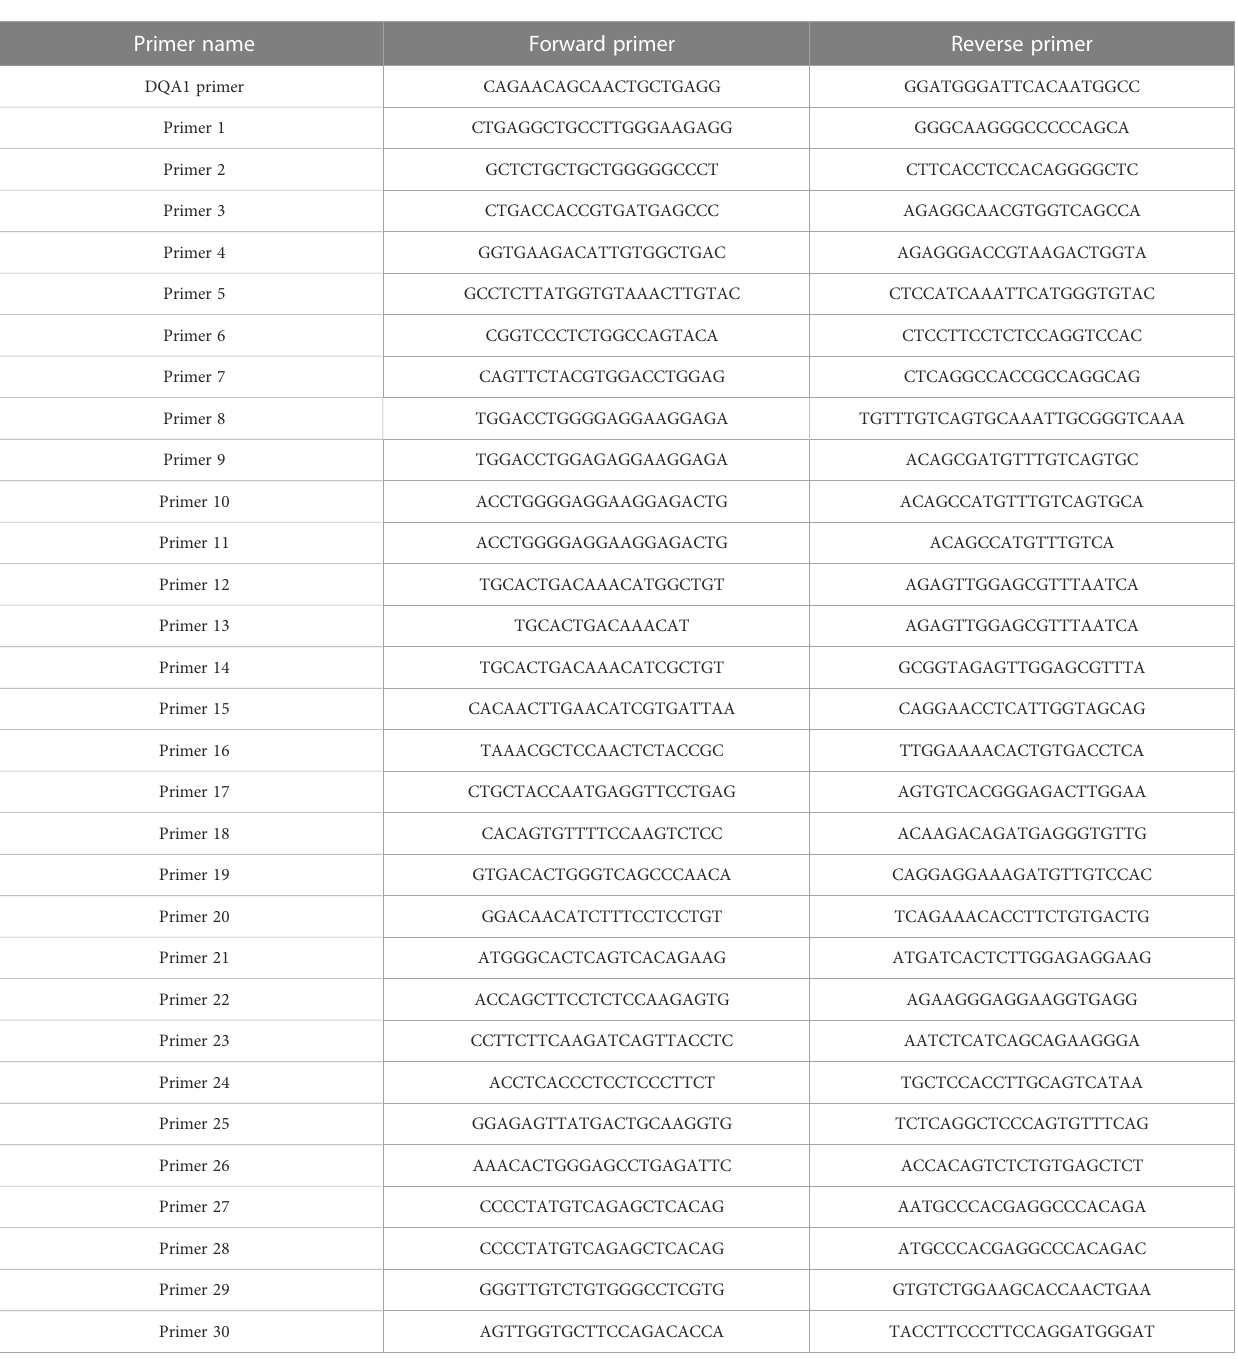
TABLE 1 Speci fi c primer